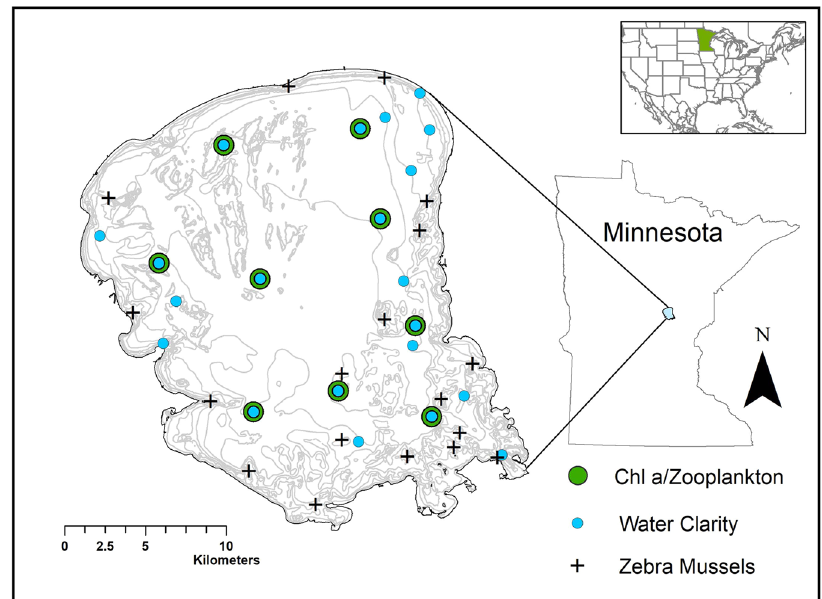
Fig. 1 Map of Lake Mille Lacs 78,79 . Nine zooplankton/chlorophyll a sampling stations (green circles), 18 zebra mussel transect locations (black crosses), and 21 water clarity stations (blue circles) were widely distributed across the lake. The depth contour lines (gray) are at 1.5 m intervals. Inset: Location of the state of Minnesota in the United States 88,89